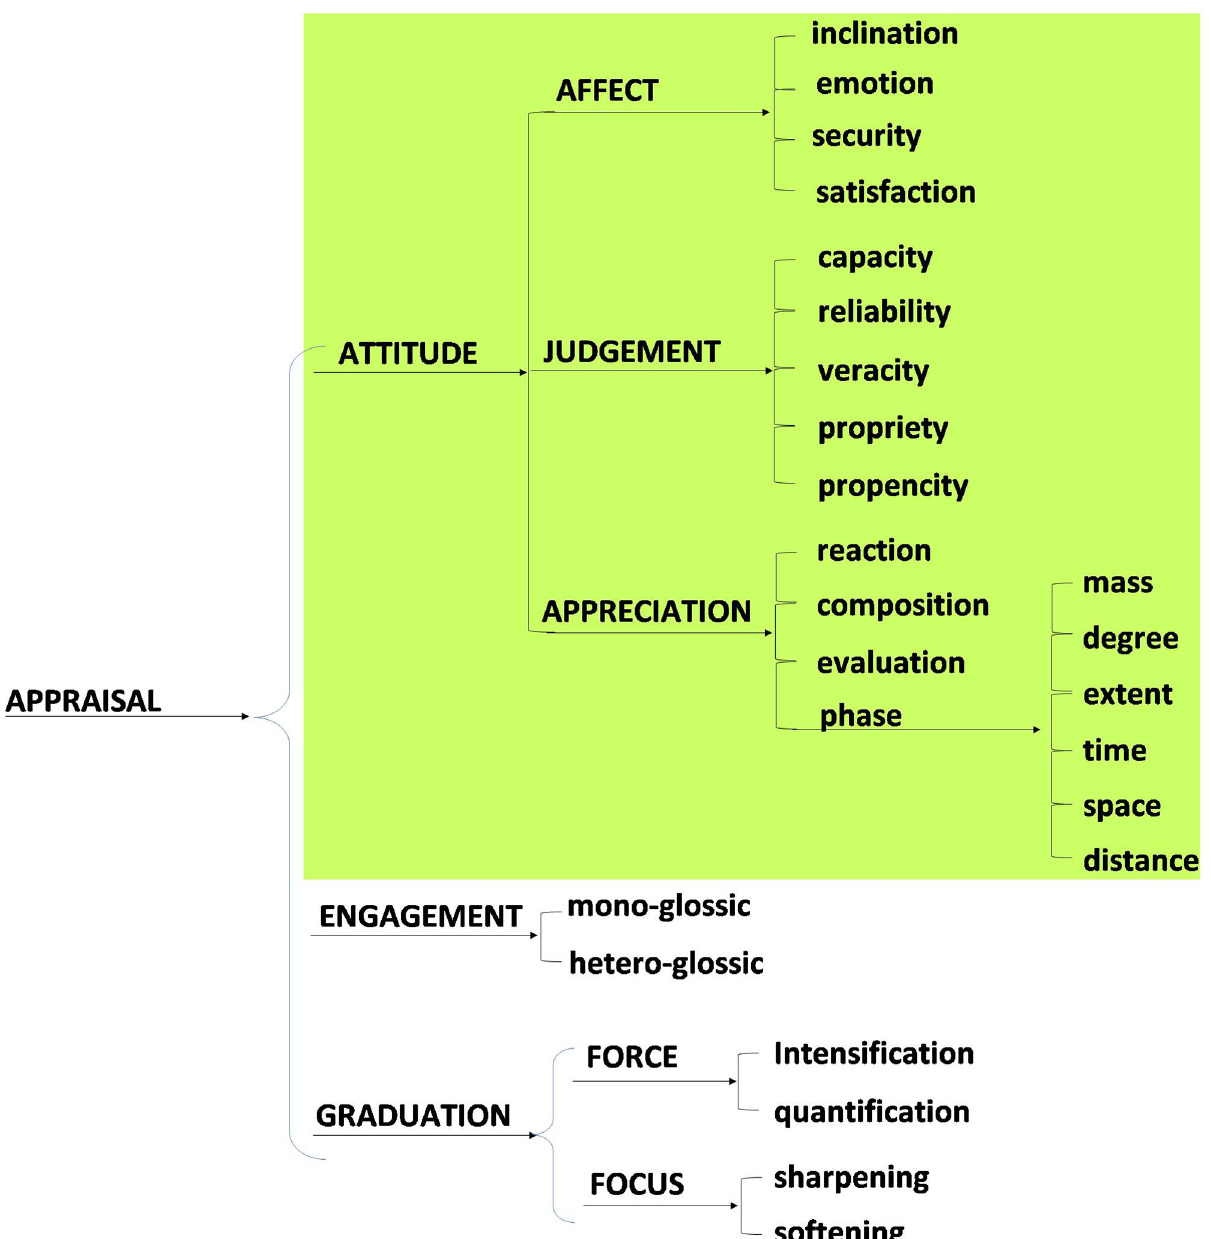
Fig 8. System network of APPRAISAL in Japanese from the interpersonal metafunction. This was constructed by transfer comparison following Martin and White [52]. The current annotation scheme incorporated the items in the green-colored portions.